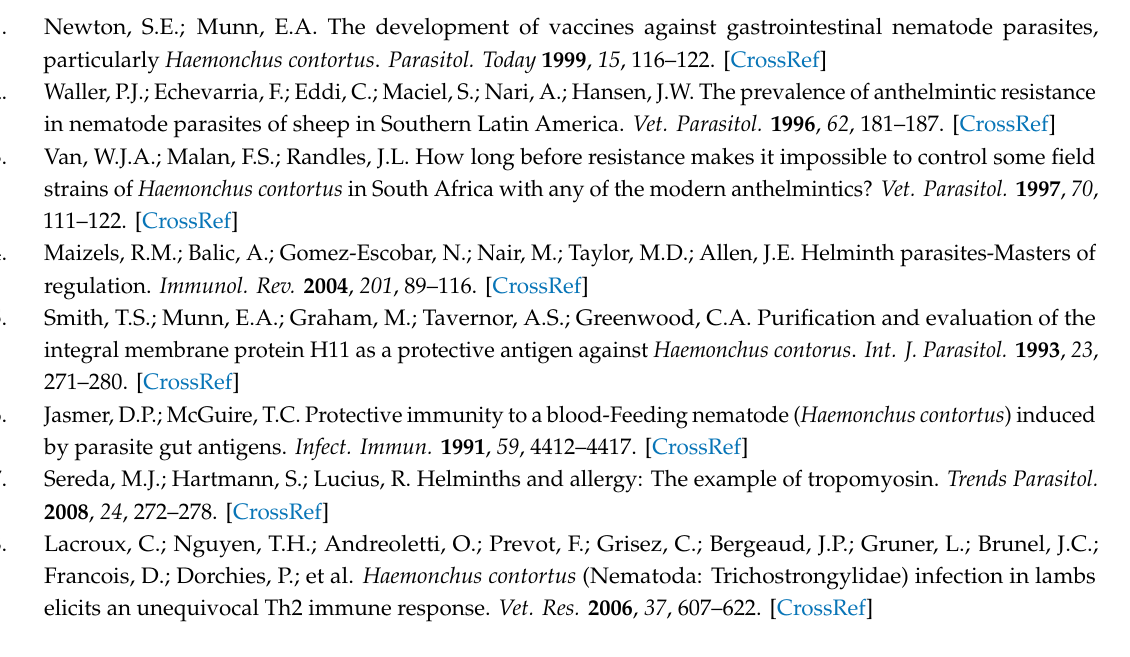
Figure S1: Cloning and expression of Hc-TpMy gene, Figure S2: Comparison of rHc-TpMy amino acid sequences to that of other nematode species available on GenBank database, Figure S3: N-terminal signal peptide prediction in rHc-TpMy